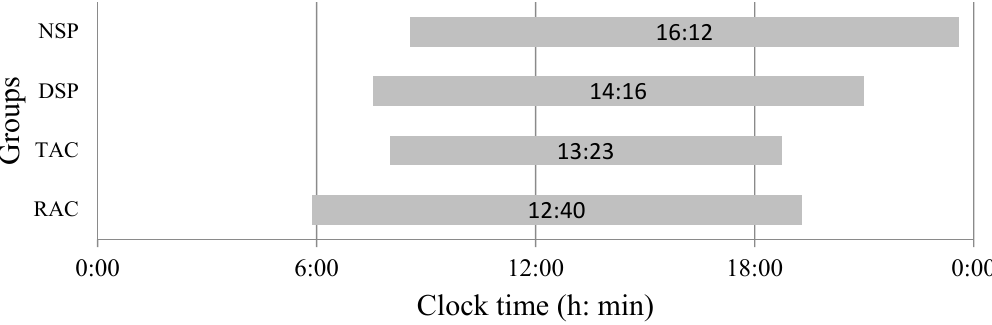
Figure 4. Average eating timing (h:min) and duration (h), according to groups. Mid-points (h:min) of the eating period are shown within the bars. Rural = RAC, town = TAC, city-day workers = DSP and city-night workers = NSP. Mean ± SD eating duration: NSP: 14.6±1.4 h; DSP: 13.2±0.6 h; TAC: 11.7±0.25 h; RAC: 13.4±0.3 h.